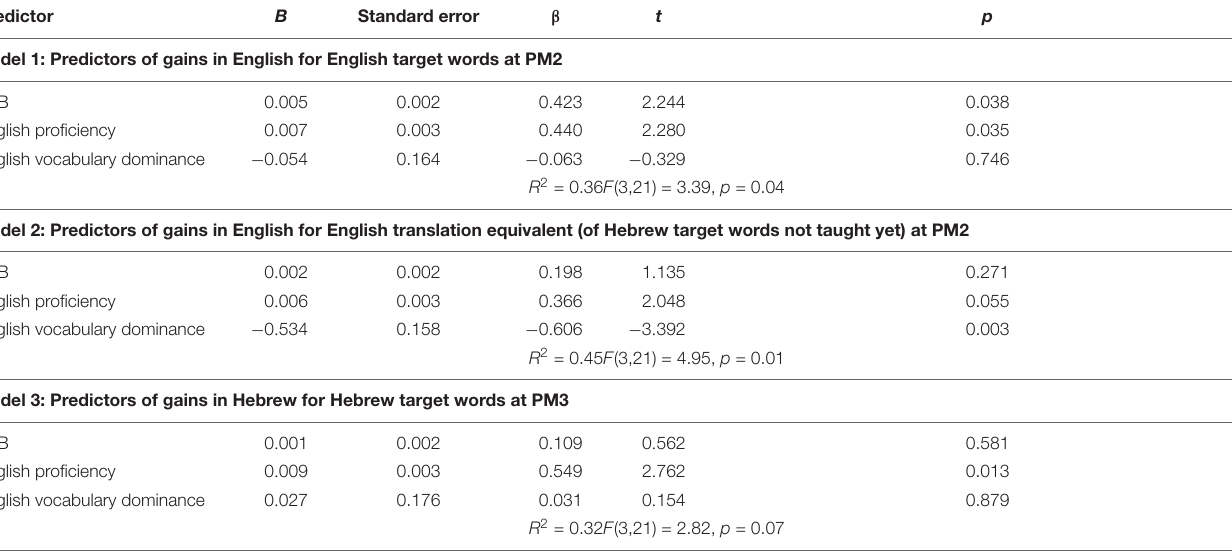
TABLE 6 | AoB, English proficiency, and English vocabulary dominance as predictors in regression models. Predictor B Standard error